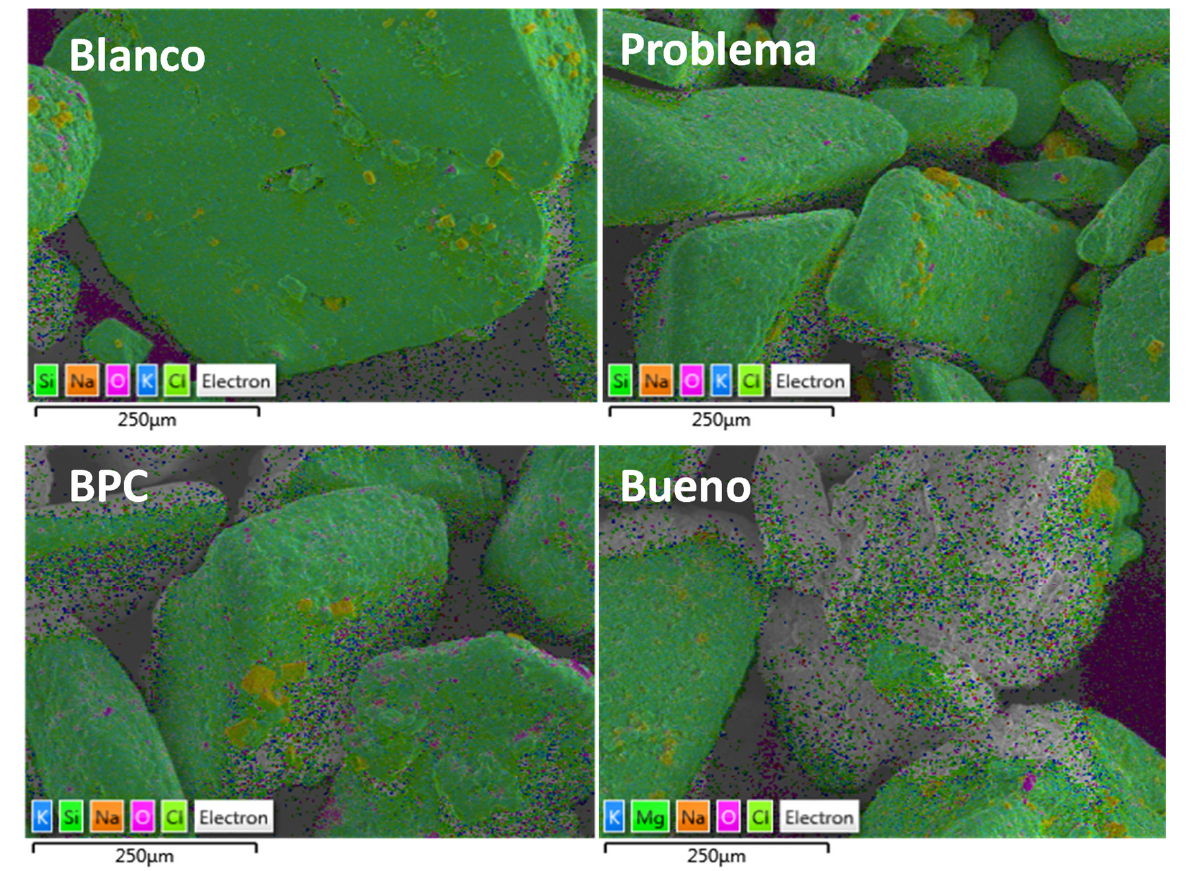
Figure 4. Distribution of elemental chemical composition of KCl minerals from different deposits using EDS-SEM.